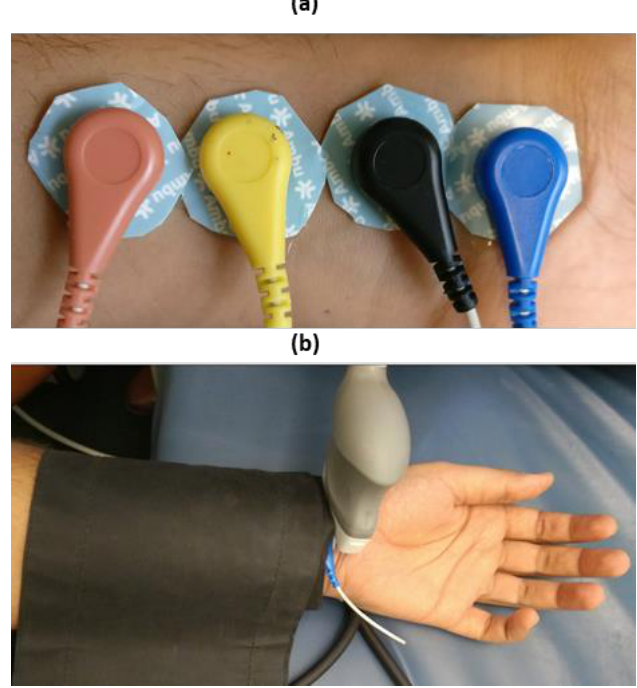
Figure 2. ( a ) Electrode setup for impedance measurements at forearm section. ( b ) Ultrasound and impedance measurement setup with cuff pressure at 200 mmHg.